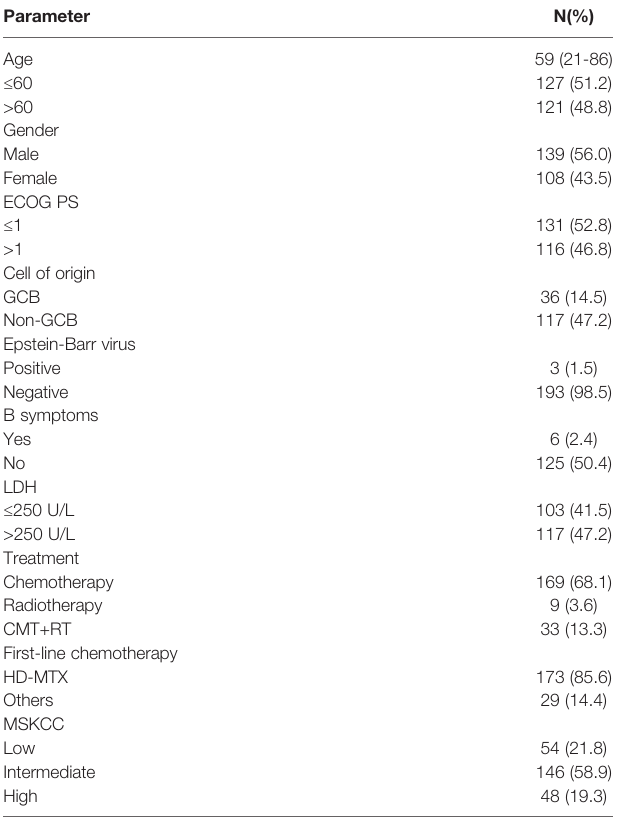
TABLE 1 | Clinico-pathological characteristics of 248 patients with PCNSL.